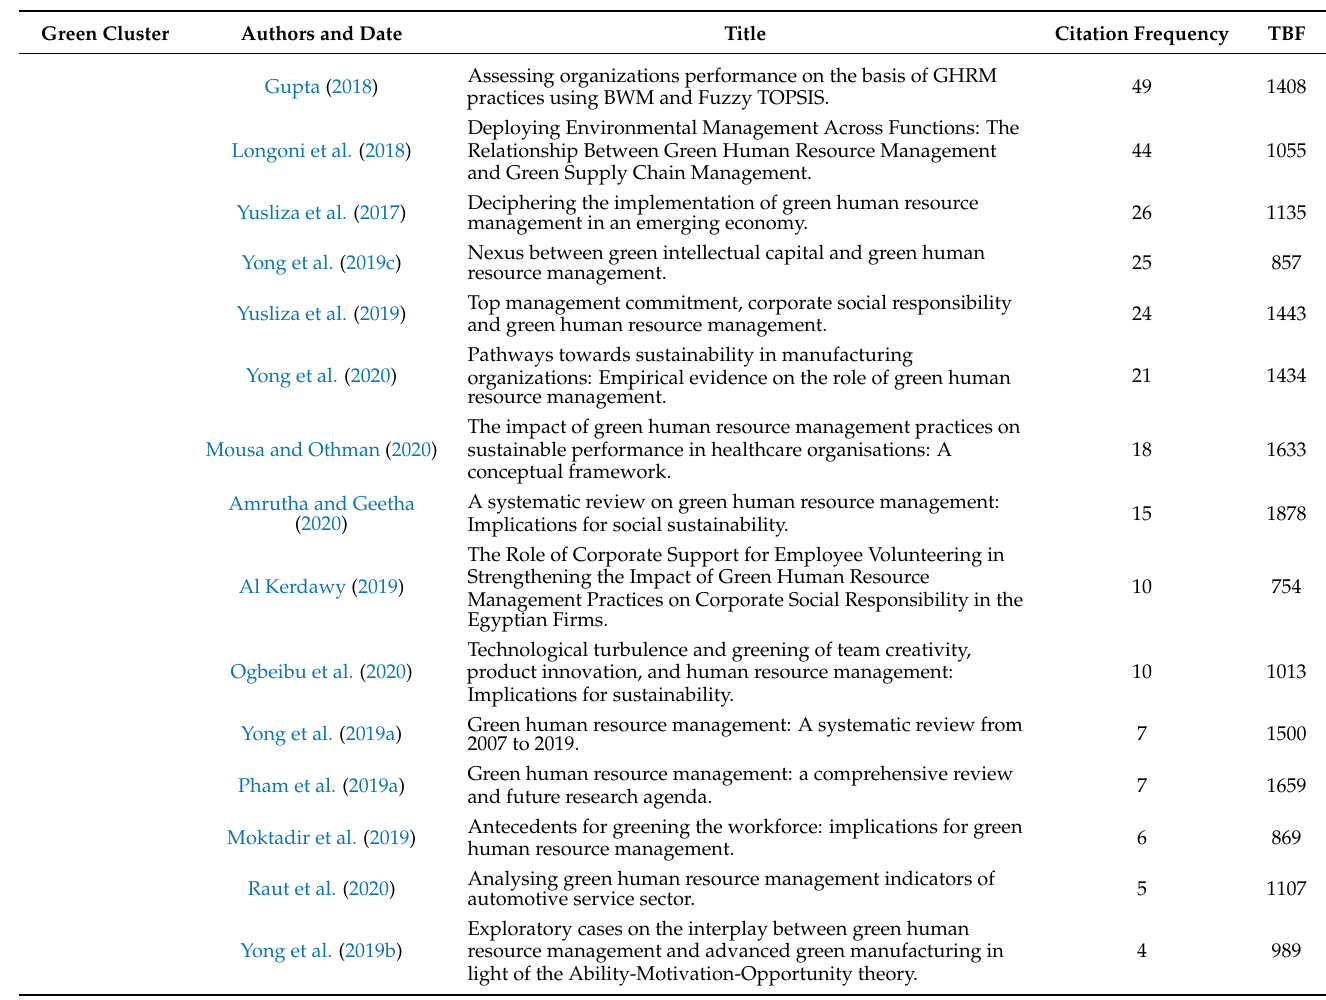
Table A3. Publications from the bibliographic coupling analysis—green cluster.